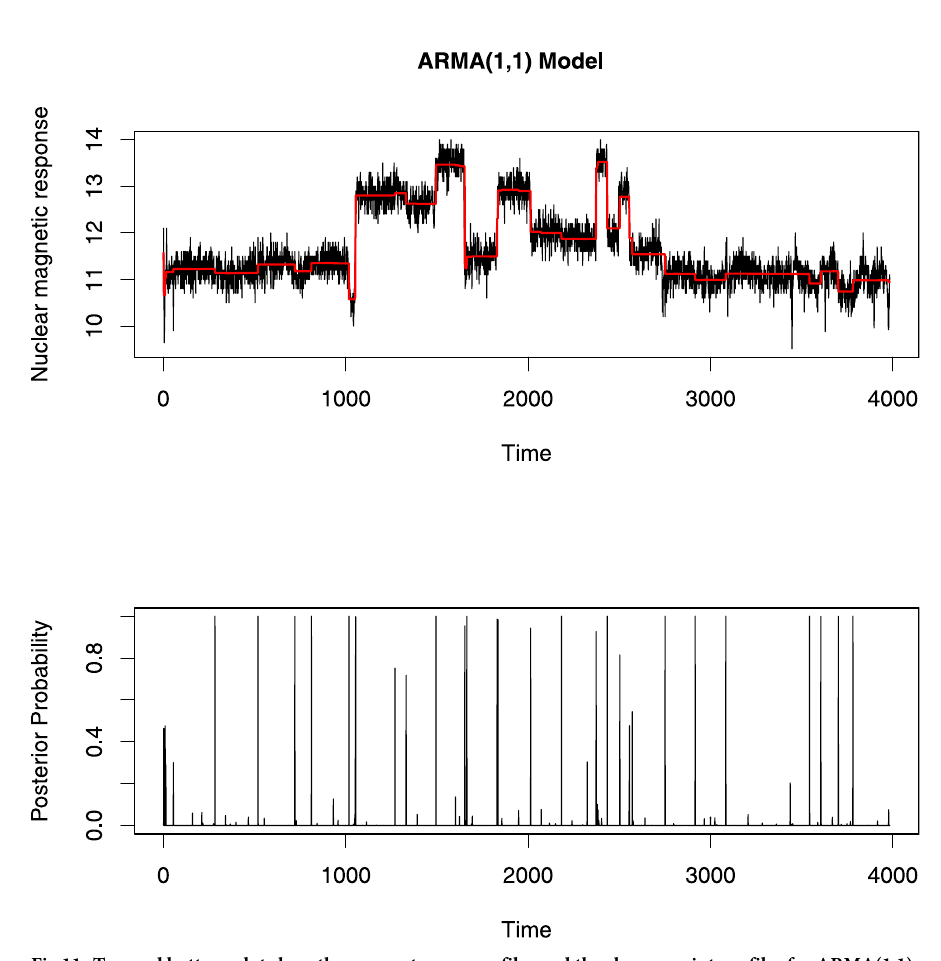
Fig 11. Top and bottom plot show the segment mean profiles and the change-point profiles for ARMA(1,1) model respectively. These change-points and segment means are almost identical to those identified using the MA(1) model.